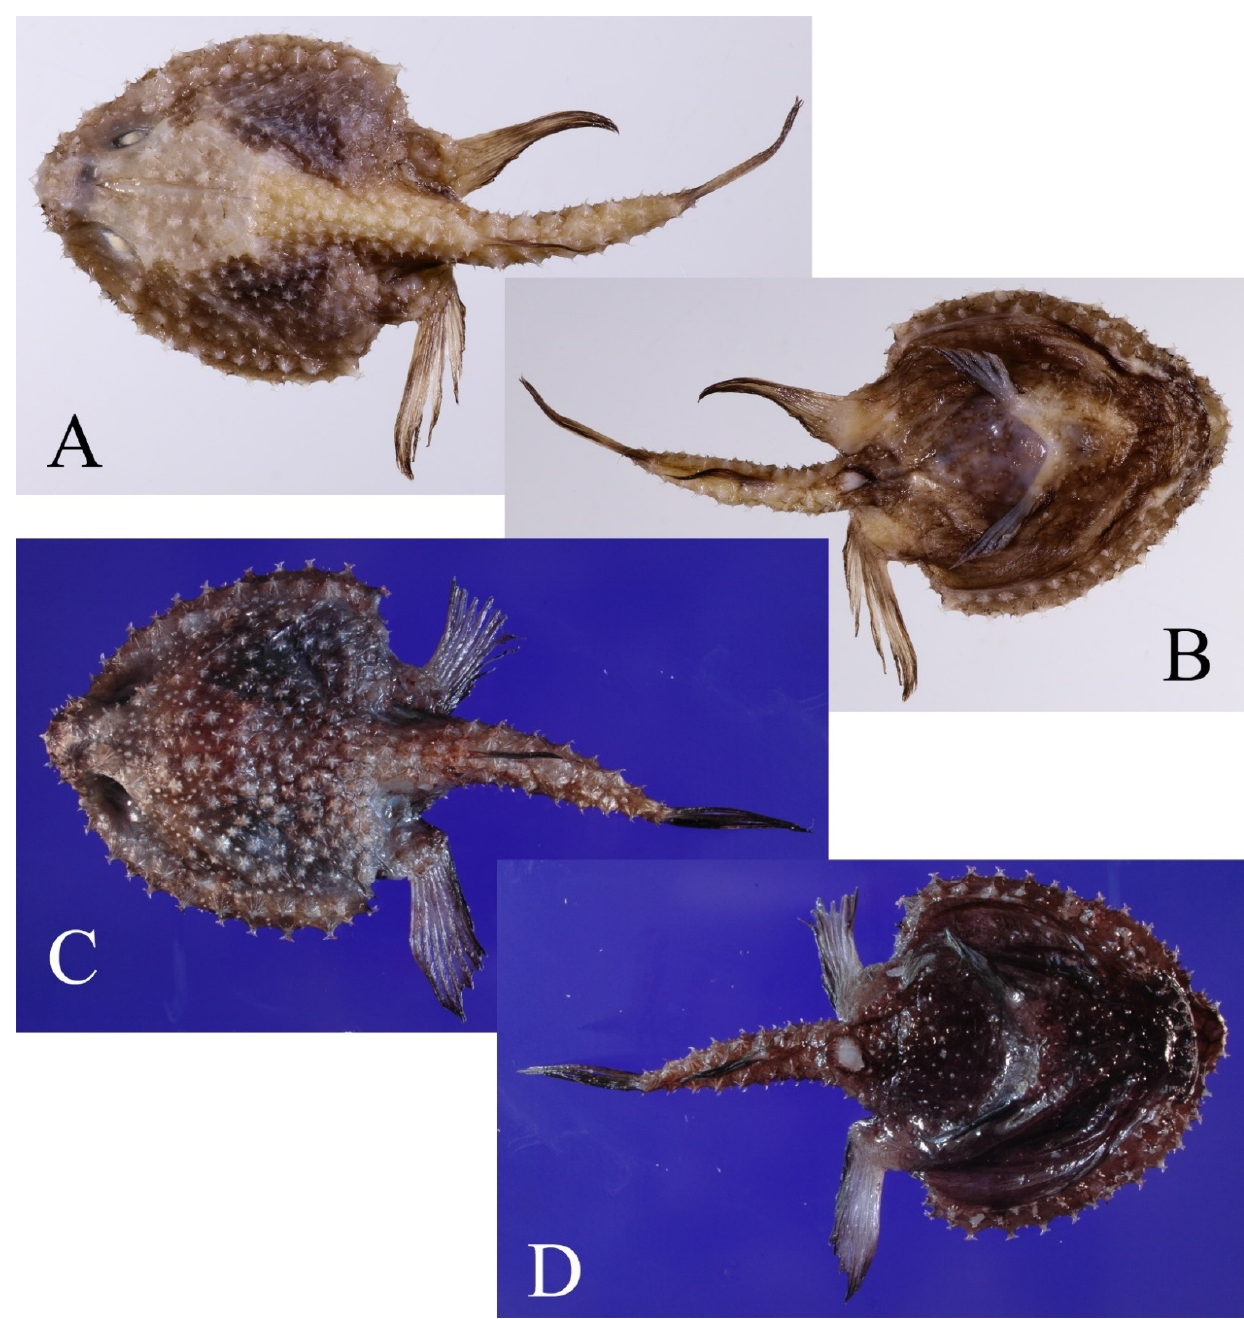
Figure 13. Halieutopsis kawaii sp. nov. ( A , B ). Holotype, ASIZP66383, 79.4 mm SL, preserved, photos by C.-N. Tang. ( C , D ). Paratype, HUMZ194271, 83.6 mm SL, fresh, photos courtesy of HUMZ. ( A , C ). Dorsal view. ( B , D ). Ventral